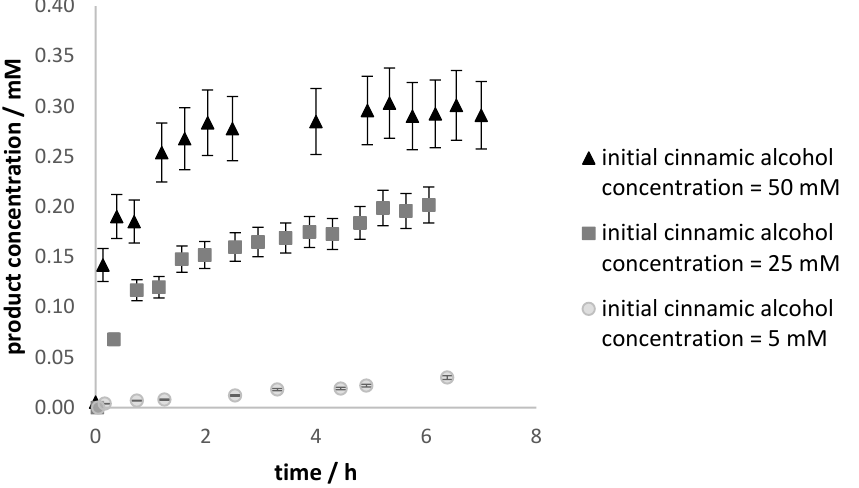
Figure 4. Operational results for the production of cinnamyl cinnamate depending on the time for three different initial cinnamyl alcohol concentrations (V orga = 0.6 L, V aq = 0.6 L, m Lipase = 8 g, c int, acid = 50 mmol/L).